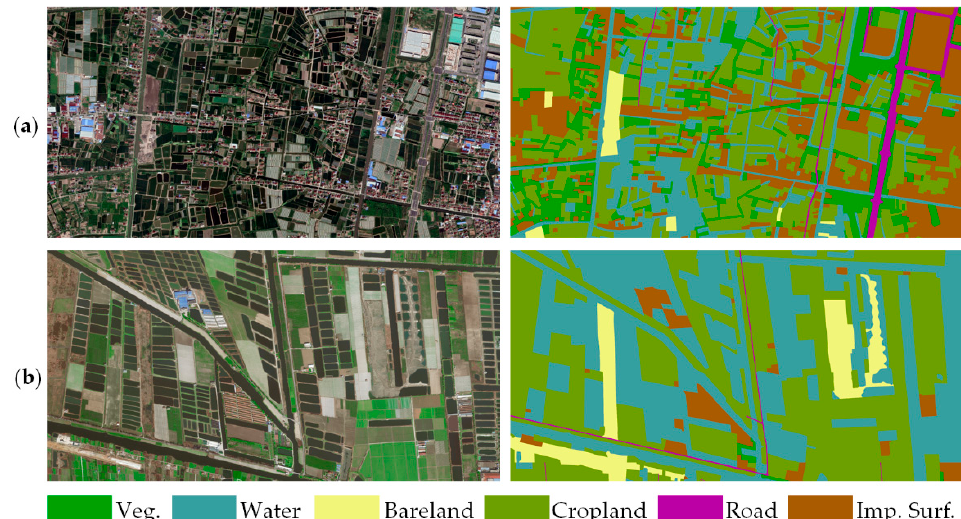
Figure 5. Representative examples of the Shanghai and Zhejiang datasets. ( a ) Images and corresponding annotated ground truth of the Shanghai dataset, ( b ) Images and corresponding annotated ground truth of the Zhejiang dataset. Table 1. Pixel statistics among categories for Shanghai and Zhejiang datasets.